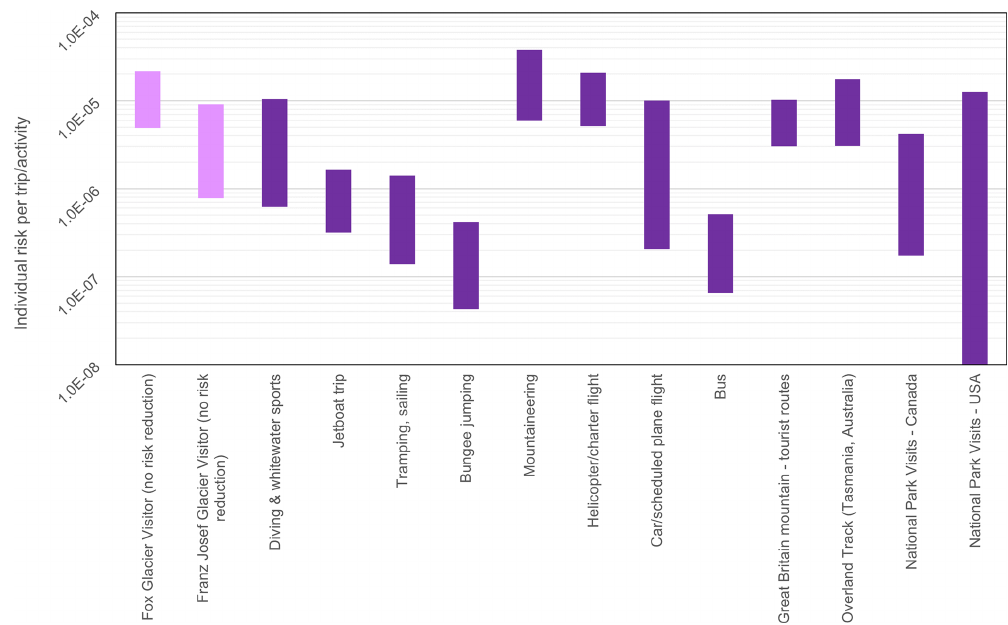
Figure 12. Quantitative estimates of individual risk per trip for Fox Glacier and Franz Josef Glacier visitors compared against popular tourist activities, modes of transportation used to access the glaciers, and individual risk per trip to national parks overseas (sourced from Taig, 2022a, b). The band range for each activity represents both the statistical uncertainty and uncertainty in the denominators of units of activity undertaken (see Taig, 2022a,